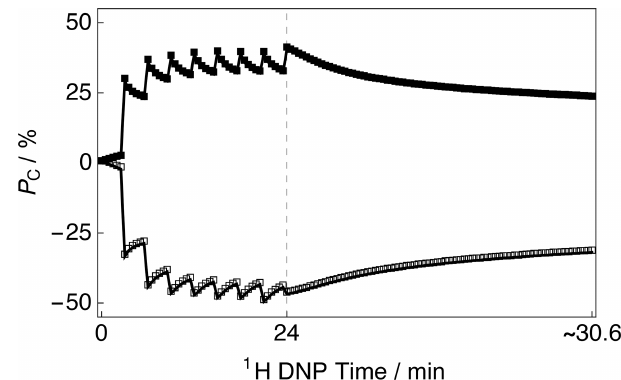
Figure 2. Experimental 13 C polarization P C CP build-up curves and subsequent 13 C signal decays as a function of 1 H DNP time acquired at 7.05T ( 1 H nuclear Larmor frequency = 300.13MHz, 13 C nuclear Larmor frequency = 75.47MHz) and 1.2K with a sin- gle transient per data point. The presented data were acquired by using the rf pulse sequence depicted in Fig. 1. Black filled squares: positive microwave irradiation; black empty squares: negative mi- crowave irradiation. The vertical dashed line denotes the 1 H DNP time at which the 1 H NMR signal was destroyed by a second series of saturating rf pulses (as shown by the rf pulse sequence illustrated in Fig.